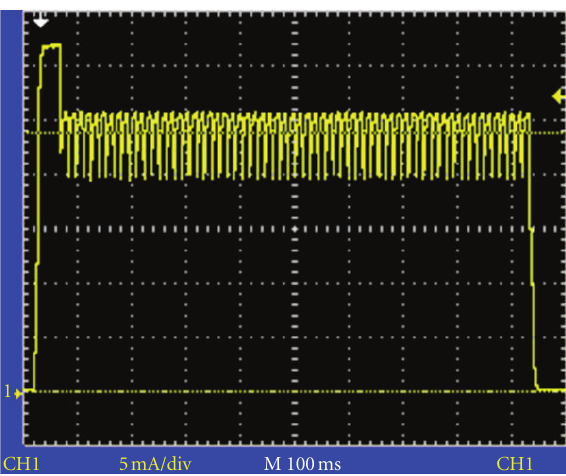
Figure 14: Measurements achieved versus expected